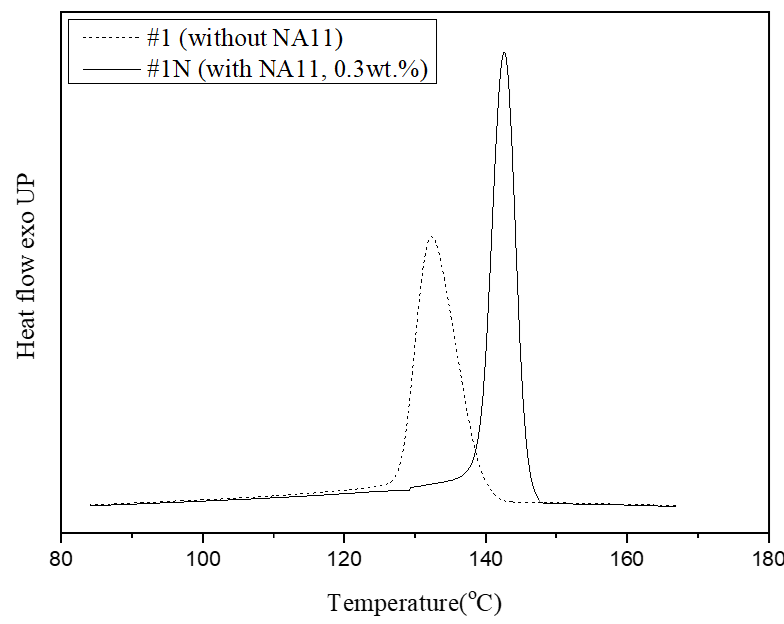
Figure 5. Non-isothermal crystallization peak shifts of PVDF with and without the nucleating agent at 10 °C/min.